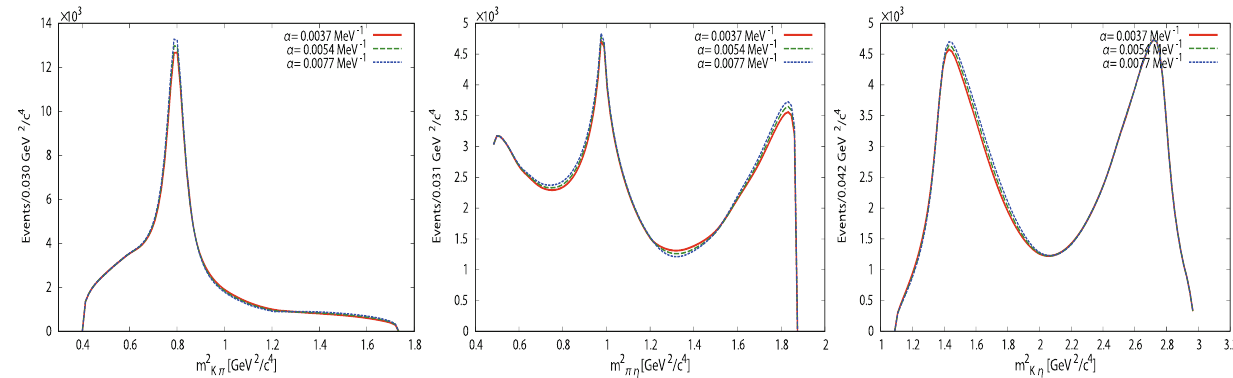
Fig. 11 Effect on the three mass distributions of the different extrapolations of Eq. (27) in the chiral amplitudes